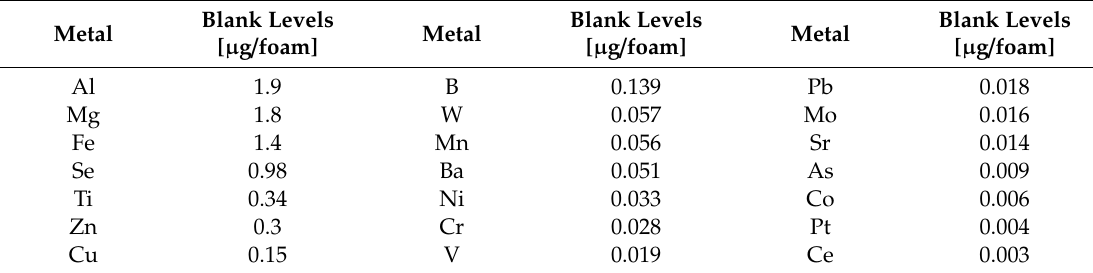
Table 4. Blank levels of elements in nanoparticle respiratory deposition (NRD) sampler foam (mean of ten foam pieces scaled to the size of that used in the sampler, data from Wisconsin State Hygiene Laboratory, Madison, WI,